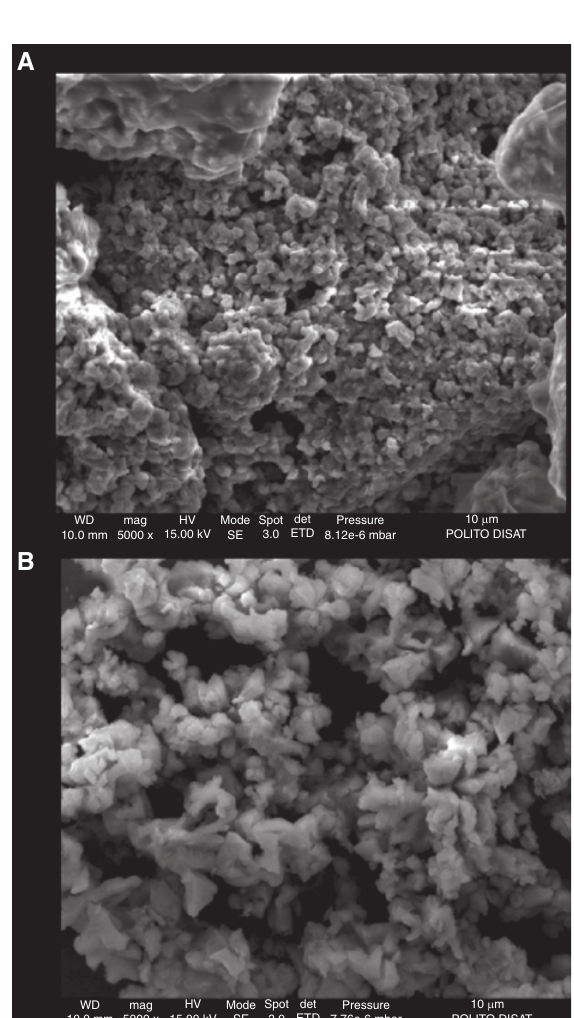
Figure 10: SEM images of catalyst of ZnO (A) and CaO